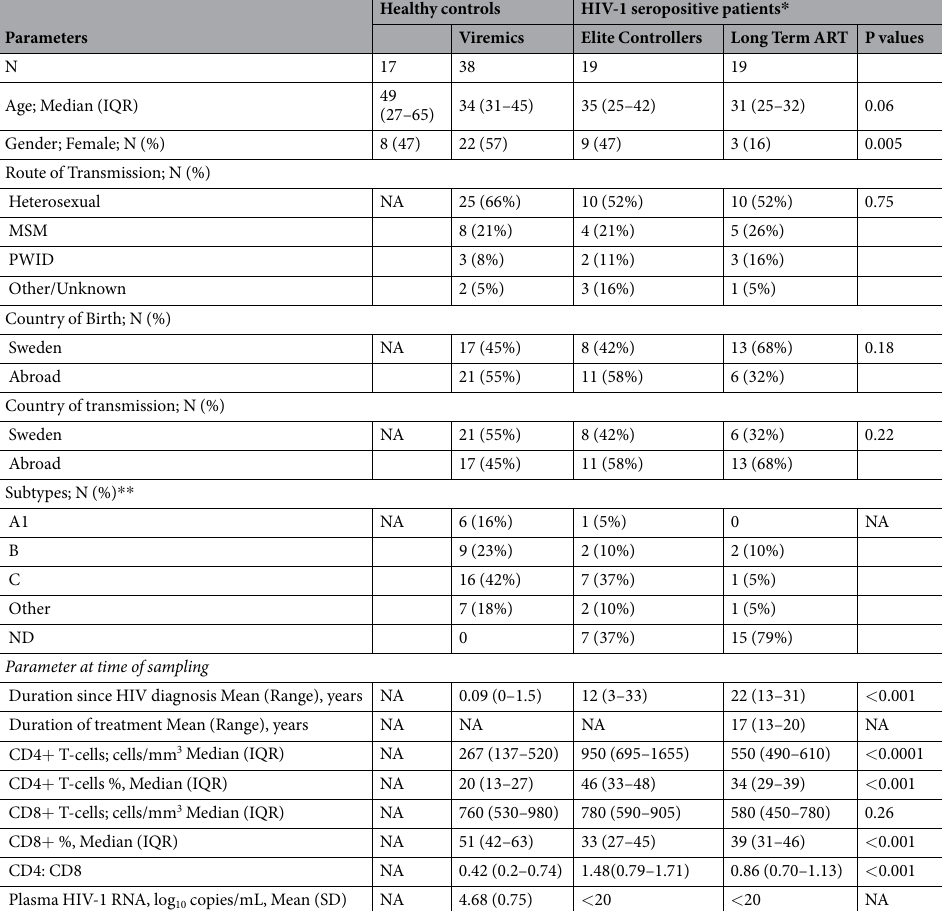
Table 1. Patients’ demographic and clinical characteristics. Viremics = untreated patients with detectable viremia; Long Term ART: patients who have received antiretroviral therapy without any viral blips or virological failure since initiation of therapy; NA: Not applicable. ** Some of ECs subtyping was based on the Gag or LTR